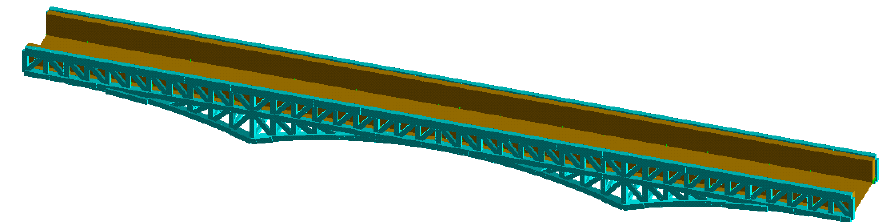
Figure 6. 3D finite element model (FEM) of the steel truss aqueduct.